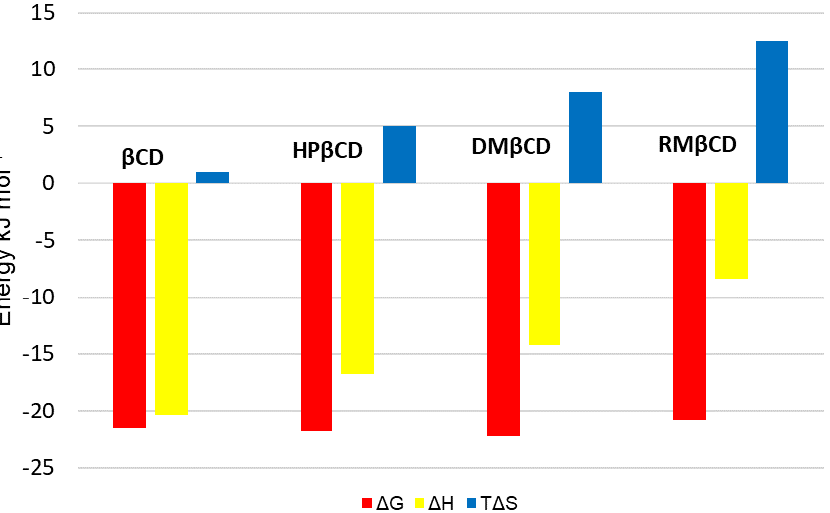
Figure 3. Binding free Gibbs energy ( ∆ G), enthalpy ( ∆ H), and entropy factor (T ∆ S) of inclusion complex formation between SRT and: β CD [41], DM β CD [41], HP β CD [42], RM β CD (this work).